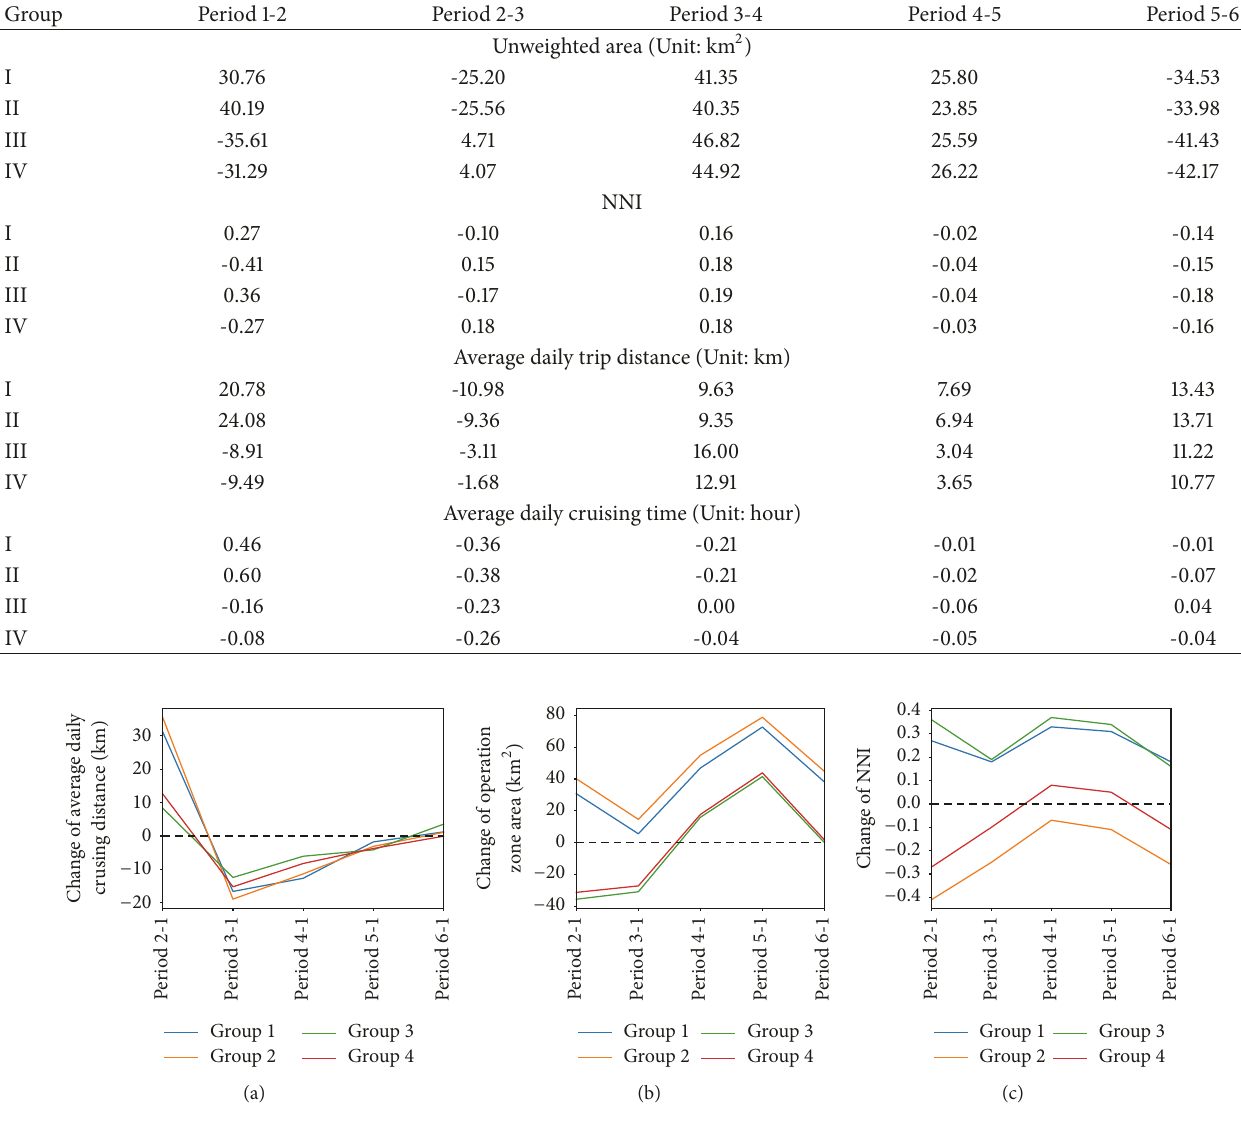
Figure 4: The change trends of each group’s average daily cruising distance (a), operation zones area (b), and NNI (c) compared with Period